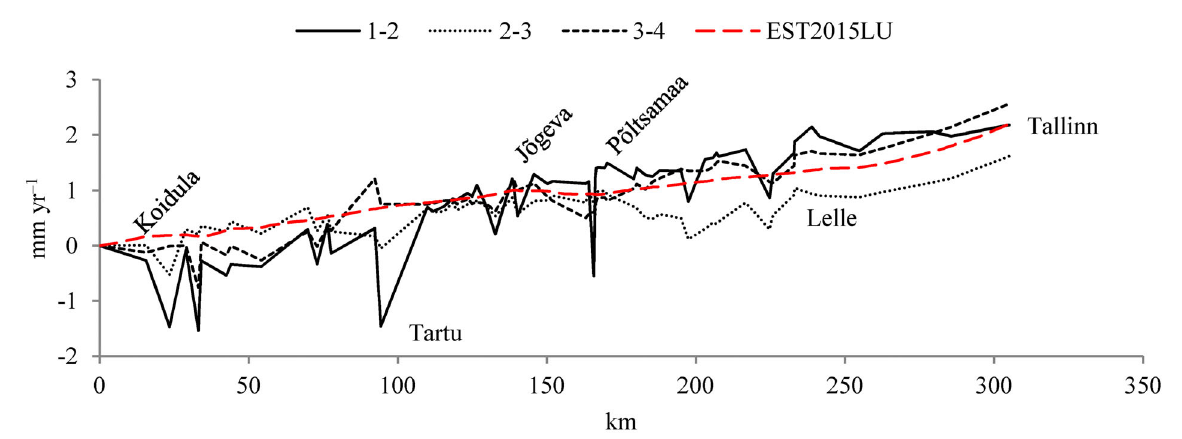
Fig. 5. Profile of the raw (unadjusted) vertical velocities of the benchmarks between the first and second (1–2), second and third (2–3) and third and fourth (3–4) levellings along the Koidula–Tartu–Jõgeva–Põltsamaa–Lelle–Tallinn levelling line (Fig. 1) relative to Koidula. The profile of the EST2015LU model (Fig. 4) along this line relative to Koidula was added for